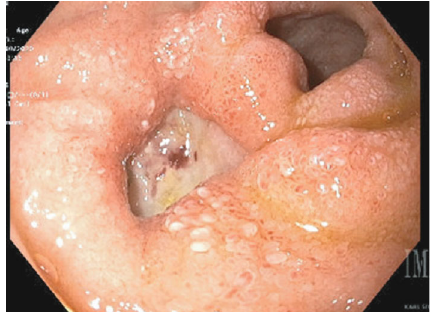
Figure 3: EDG shows a large fi brotic, chronic-appearing, penetrating duodenal bulb ulcer with fi stulous tract in communication with the surgical